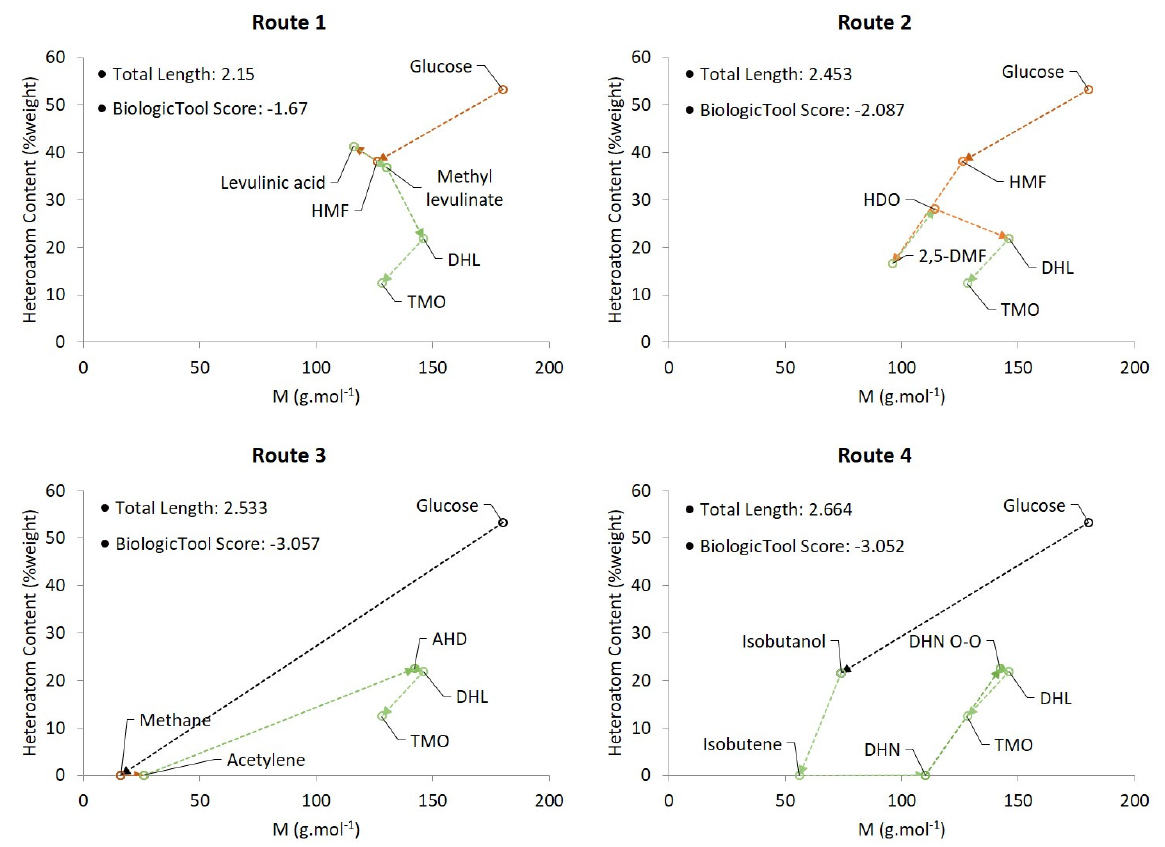
Figure 1. Plots generated by the BioLogicTool , showing the pathways of each route 1–4 to TMO from a common glucose feedstock for each of the four routes. The colour of the arrow is determined by the yield of that step (see Table 2); green being the highest, red being the lowest, and black where no or insufficient data was available. The BioLogicTool does not consider the possibility that a synthetic pathway requires the merging of two routes at any point in the synthesis. As such, the larger numerical value (ignoring minus sign) for the BioLogicTool score and Total Length for any convergent pathway has been presented, this deemed more representative where a convergent synthesis is used. BioLogicTool plots were prepared using the spreadsheet available as supplementary information accompanying the original 2019 article by Lie et al. [9].